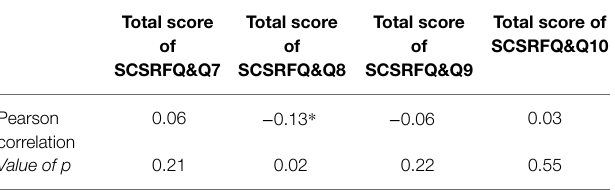
TABLE 6 | Pearson correlation of total score for the SCSRFQ with each of the sports participation